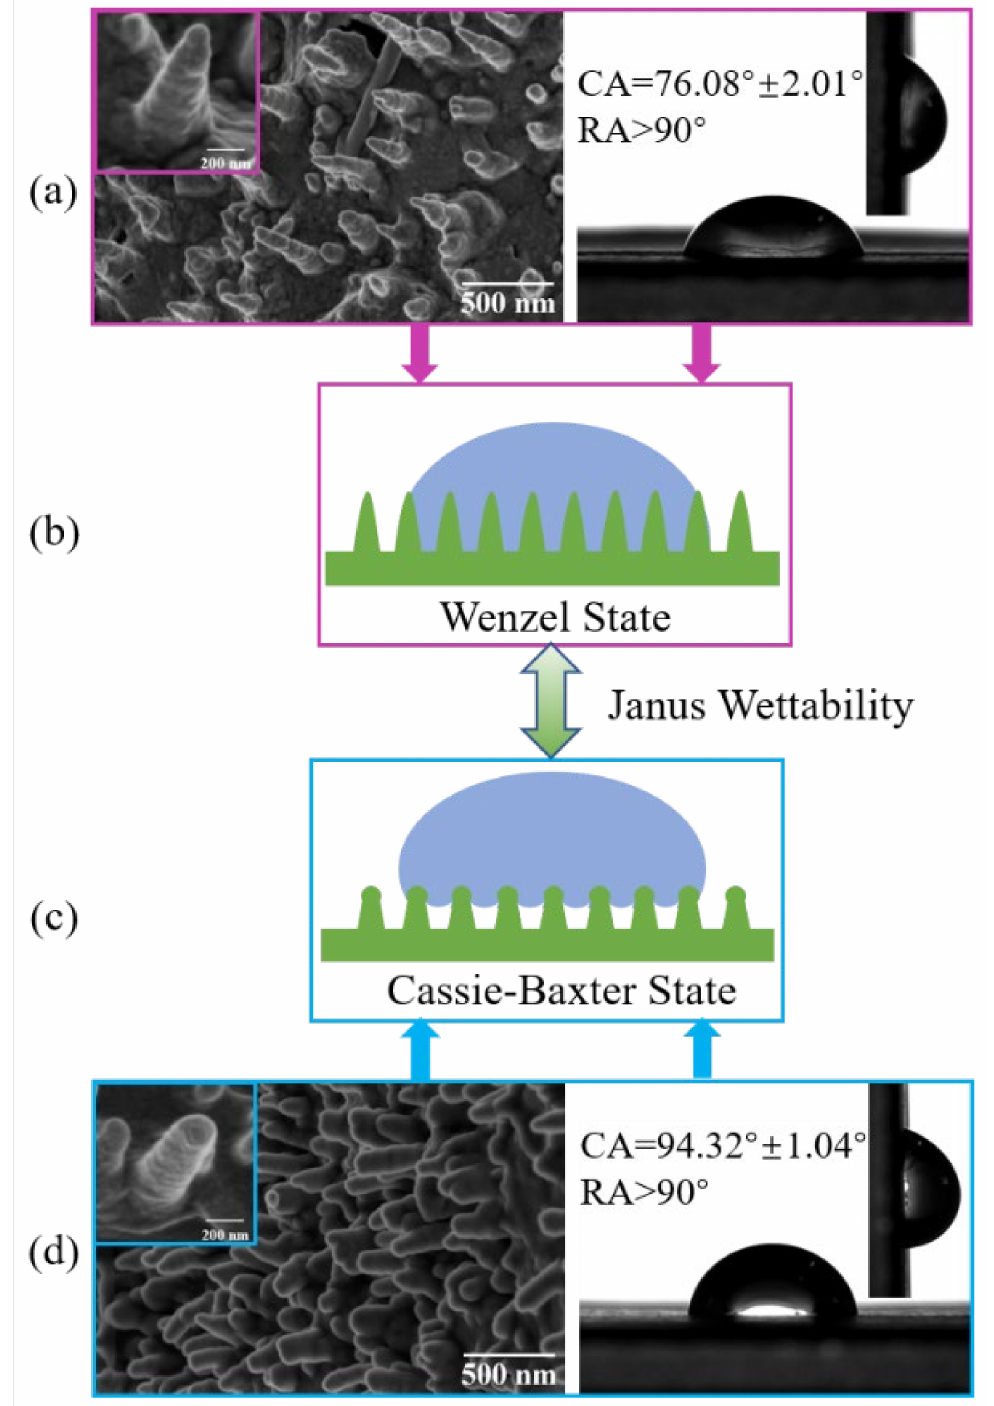
Figure 2. Banana leaves surface characteristics. ( a , b ) The adaxial side; ( c , d ) the abaxial side; ( a , d ) the nanopillar structure on the left and the contact angle and rolling angle on the right; ( b , c ) the wetting